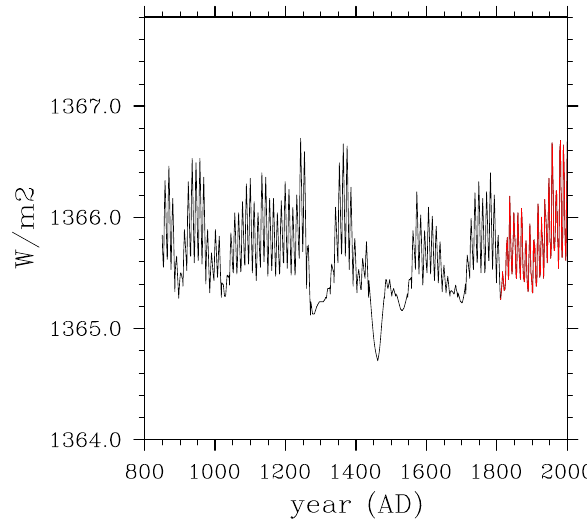
Fig. 19. Reconstruction of total solar irradiance since year 850AD. The black line indicates data from Steinhilber et al. (2009), the red line data from Wang et al.